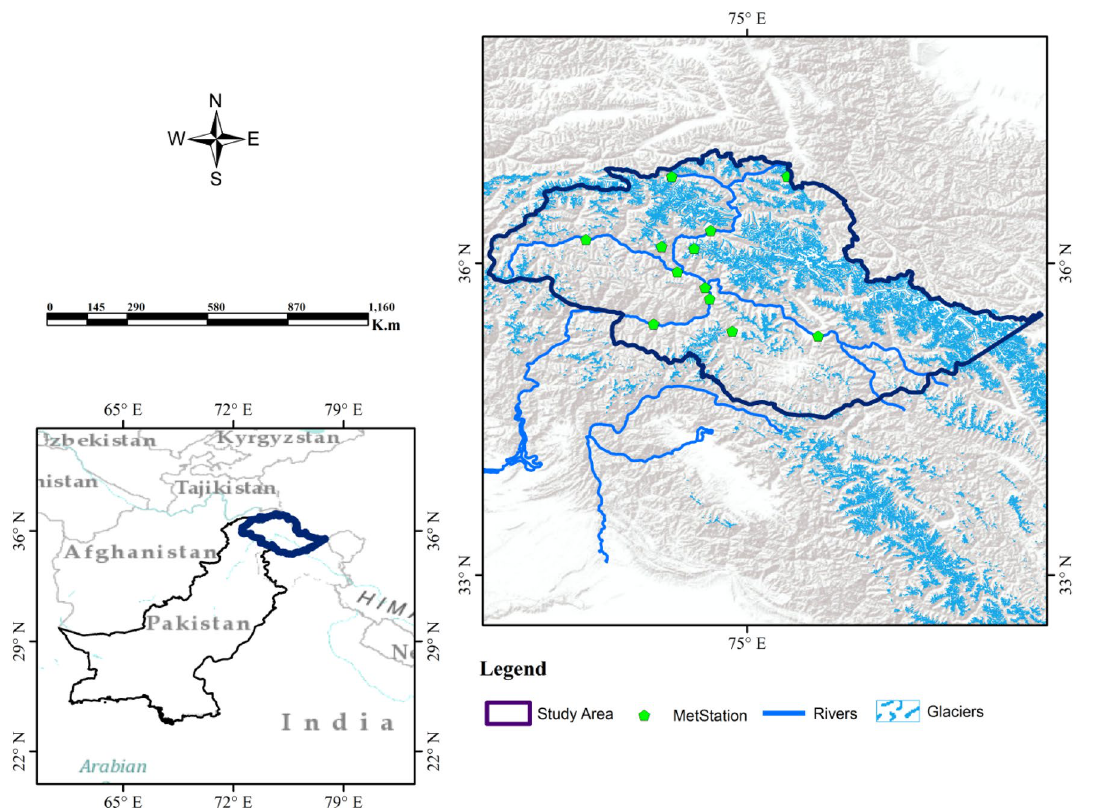
Fig. 1 Study area and weather stations’